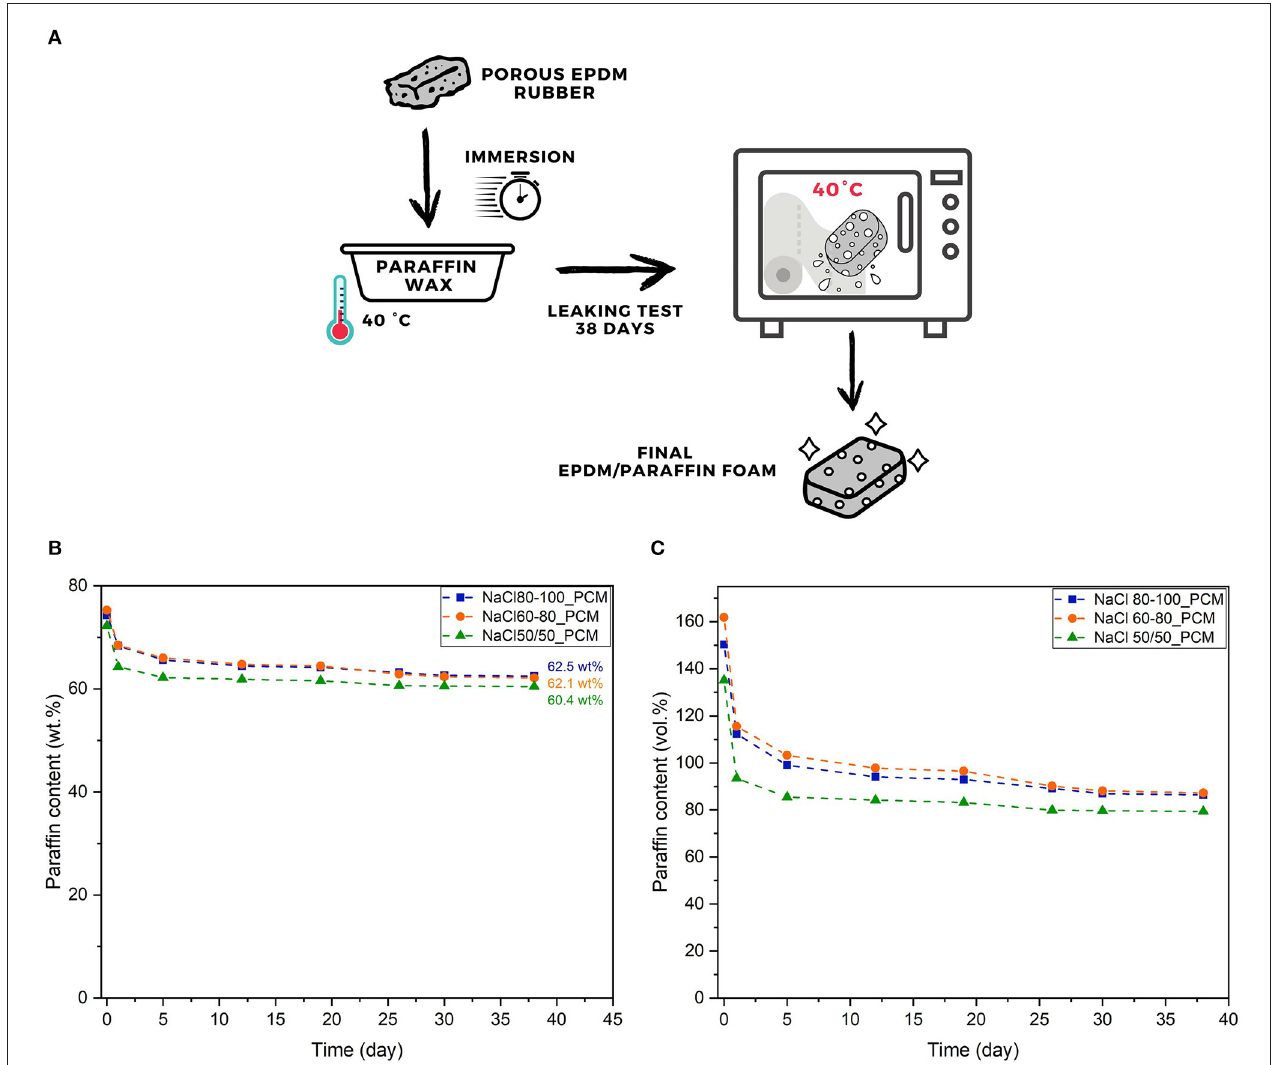
FIGURE 1 | Scheme of a paraffin impregnation process for the production of the thermal energy storage (TES) ethylene-propylene diene monomer (EPDM) foam (A) and the results of the leaking tests at 40 ◦ C in terms of: (B) paraffin weight percentage, and (C) paraffin volume percentage up to 38